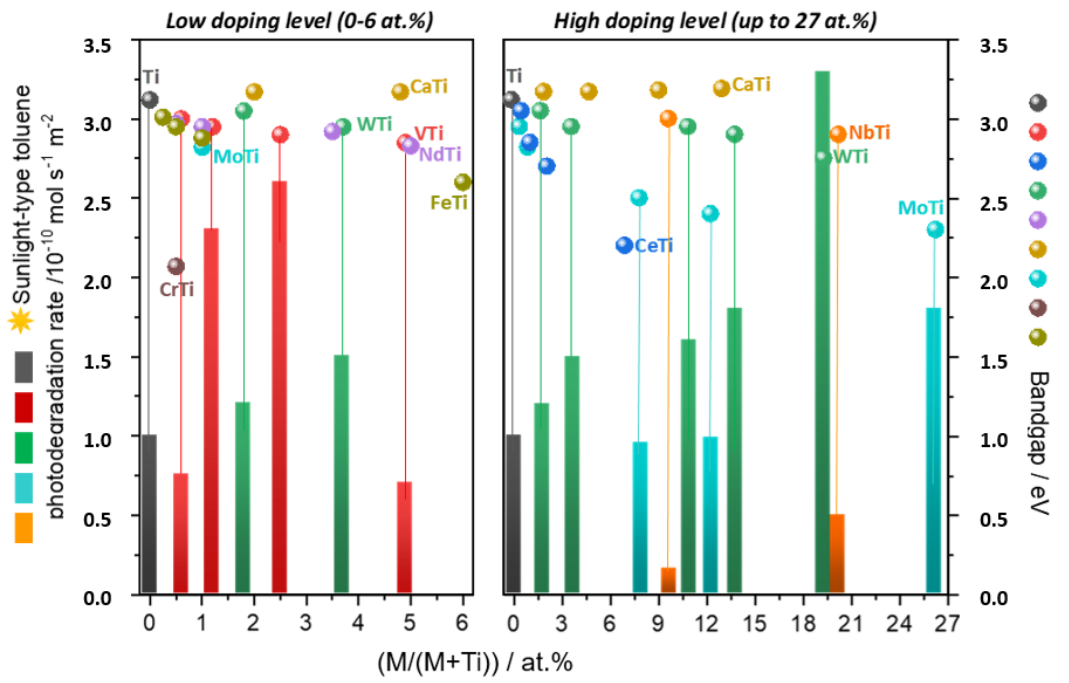
Figure 1. Band gap energy and photoactivity under sunlight-type irradiation vs. doping level for metal-doped TiO 2 systems.